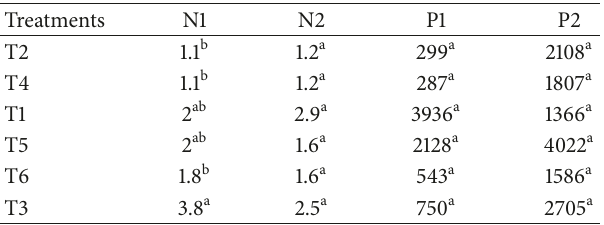
Table 4: Means of nitrogen and phosphorous levels.